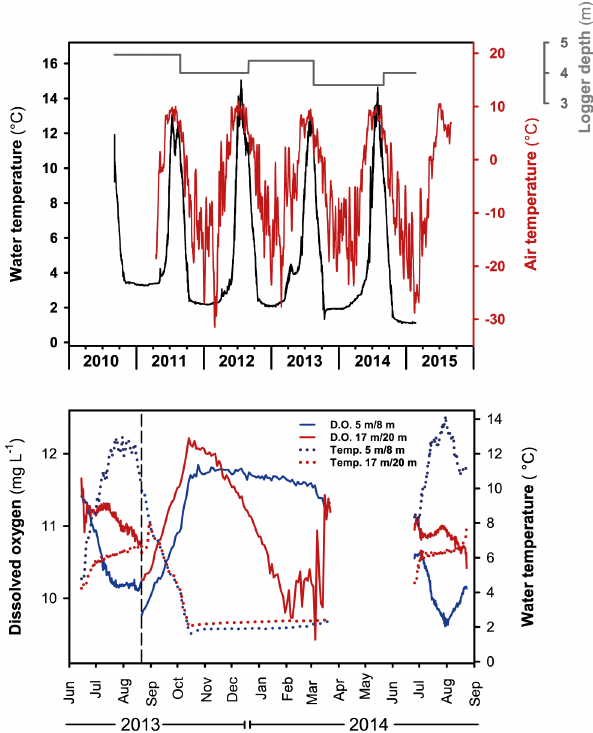
Figure 13. Upper figure: graph displaying the variations in lake wa- ter temperature at about 4m water depth and air temperature during the period from 2011 to 2015. The black line represents lake water temperature, the red line the air temperature, and the grey line rep- resents the exact depth of the lake water temperature logger. Lower figure: graph displaying the variations in dissolved oxygen and tem- perature during measurements in 2013 and 2014. The dashed line represents the time when the depth of the loggers was changed from 5 and 17m to 8 and